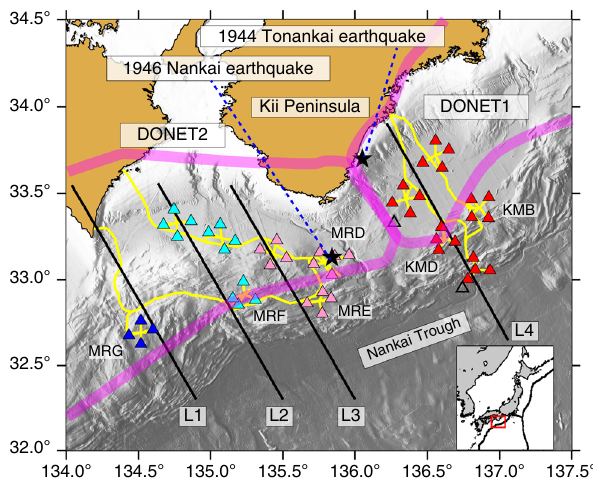
Fig. 1 Locations of stations in DONET1 and DONET2, and lines. Red triangles are DONET1 stations, and blue, pale blue, and pink triangles are DONET2 stations. Labels with three capital letters represent the node name (see details in Supplementary Fig. 1). Vs pro fi les at the stations are projected onto lines L1 – L4 in Fig. 2. Stars represent the locations of rupture initiations for the 1944 Tonankai and 1946 Nankai earthquakes 12 , and magenta line shows seismogenic zones for future great